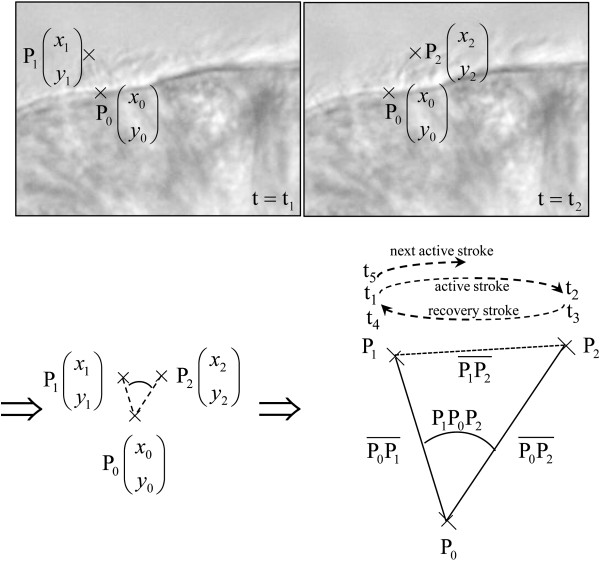
Determination of digital high-speed videomicroscopy parameters of ciliary beat pattern of a cilium. The three positions of the cilium (base of the cilium, P0, positions of the tip before the active and recovery strokes, P1 and P2 respectively) and the five time-points of beating (start and arrival of the active stroke, t1 and t2 respectively, start and arrival of the recovery stroke, t3 and t4 respectively, and start of the following cycle, t5) were measured. Twelve parameters were then determined from these measurements:.* The cilia length:
Lc=maxP0P¯1,P0P2¯ where
PiPj¯ designates the euclidean distance between the points Pi and Pj. In cartesian coordinates
PiPj¯=xi-xj2+yi-yj2*The angle of beating,
P1P0P2^, is given by the law of cosines:
P1P0P2^=ArcosP0P¯12+P0P2¯2-P1P2¯22⋅P0P¯1⋅P0P2¯*The global frequency:
Fg=1t5-t1 *The power stroke duration: Dp=(t2 - t1)*The recovery duration: Dr=(t4 - t3) *The pause after stroke: Ps=t3 - t2*The pause after recovery: Pr=t5 - t4 *The total pause: Pt=Ps+Pr*The distance travelled per
second = Lc⋅P1P0P2^⋅fg⋅1second*The area swept
per second =P1P0P2^/2⋅Lc2⋅fg⋅1second*The weighted distance travelled
per second = % of beating edges⋅Lc⋅P1P0P2^⋅fg⋅1second*The weighted area swept
per second = % of beating edges⋅P1P0P2^/2⋅Lc2⋅fg⋅1second.